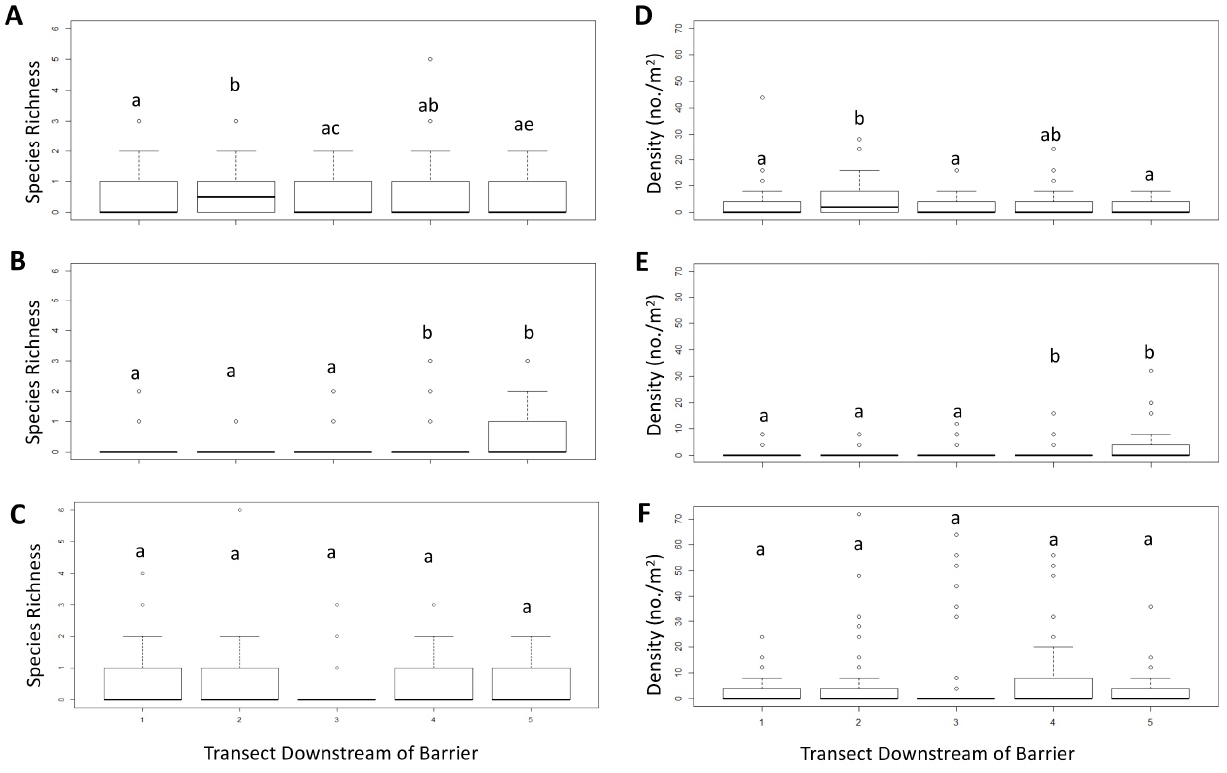
Figure 6. Mussel species richness ( A – C ) and densities ( D – F ) along a downstream gradient from anthropogenic barriers in the Lake Michigan basin, Michigan, USA. ( A , D ) = uncontrolled dams; ( B , E ) = controlled dams; ( C , F ) = dam removals. Kruskal– Wallis tests were performed independently within each subfigure and are indicated by letters above bars. Horizontal line median, box 25th and 75th quartiles, whiskers the highest and lowest values, excluding outliers, circles indicate outliers. Letters above box plots indicate statistical significance with Dunn’s